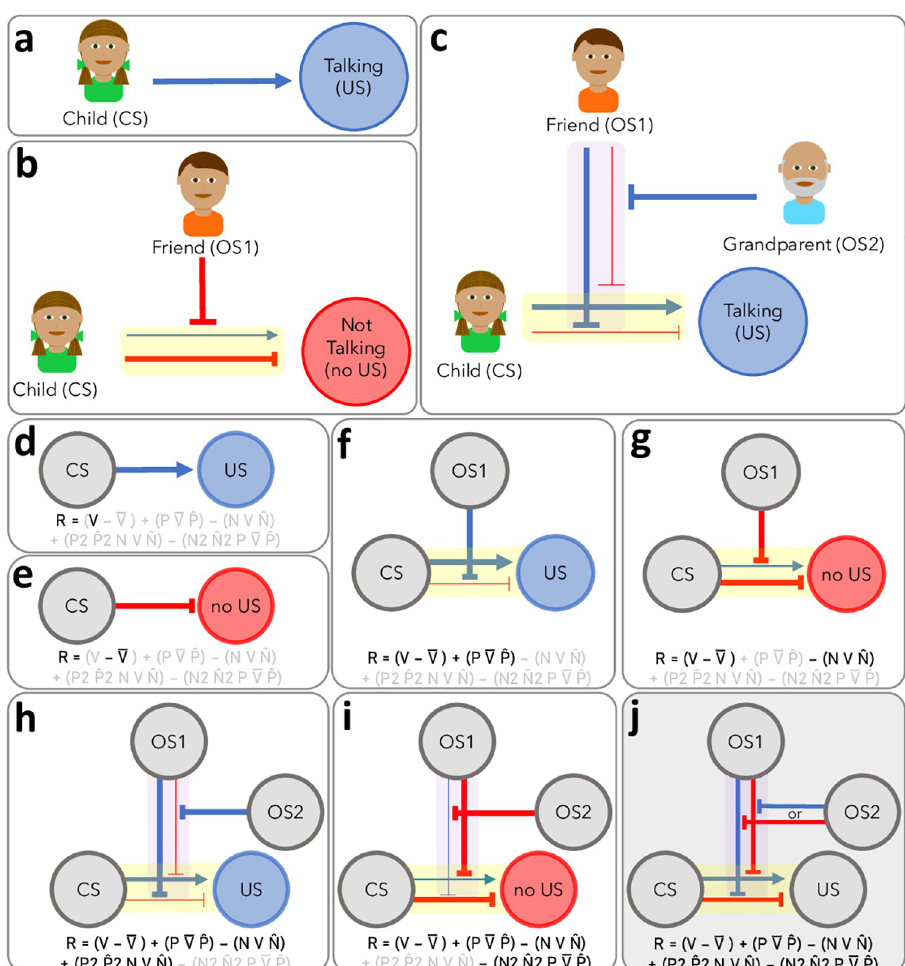
Fig 1. Hierarchical Model of 2 nd -Order Occasion Setting. Using example from main text of child, friend, and grandparent: a) direct associative learning, b) 1 st -order occasion setting, and c) 2 nd -order occasion setting. Panels d-j display: d) direct excitation, e) direct inhibition, f) 1 st -order positive occasion setting, g) 1 st -order negative occasion setting, h) 2 nd -order positive occasion setting, i) 2 nd -order negative occasion setting, and j) the total model with all associations. Our mathematical model is presented at the bottoms of panels d-j, where black/bold variables are active (i.e., values greater than 0), and gray variables are inactive (i.e., values are 0). See Table 3 for details on formulas. In the figure, circles are stimuli: unconditional stimulus (US), conditional stimulus (CS), 1 st -order occasion setter (OS1), and 2nd-order occasion setter (OS2). Blue arrows indicate direct excitation; blue line segments indicate positive occasion setting; red line segments indicate direct inhibition or negative occasion setting; yellow glow indicates CS ambiguity; purple glow indicates OS1 ambiguity; blue USs indicate US delivery; and red USs indicate US omission. While we suggest that stimulus ambiguity is a dimensional, learned property, we present it as present/absent in the figure for simplicity. Thick arrows/lines indicate activated pathways; thin arrows/lines indicate deactivated pathways. Stimulus ambiguity is required for higher-order associative learning: 1 st -order occasion setting is learned only if the CS is ambiguous and has been trained with an OS1; 2 nd -order occasion setting is only learned if the CS and OS1 are ambiguous and if the CS has been trained with an OS2. CSs have a direct predictive relationship with the US. If the CS is ambiguous (i.e., sometimes predicts the US, sometimes predicts absence of the US), then attention is broadened to other stimuli or contextual factors (i.e., to the OS1); if a stimulus that disambiguates CS reinforcement is identified and is less salient than the CS, it becomes an OS1. The OS1 modulates the CS/US association. If OS1 consistently excites the CS/US association, then OS1 is a positive OS1; if OS1 consistently inhibits the CS/US association, then OS1 is a negative OS1. If OS1 sometimes excites and sometimes inhibits the CS/US association (i.e., OS1 is ambiguous), then attention is broadened to other stimuli or contextual factors (i.e., OS2) that disambiguate how the OS1 affects the CS/ US association. If a stimulus disambiguates the effect of OS1 on the CS/US association and is presumably less salient than the OS1, 2 nd -order occasion setting is learned. If the OS2 consistently disables the OS1’s 1 st -order positive occasion setting ability, the OS2 is a 2 nd -order negative occasion setter. If OS2 consistently disables OS1’s 1 st -order negative occasion setting ability, then OS2 is a 2 nd -order positive occasion setter. Additionally, each hierarchical